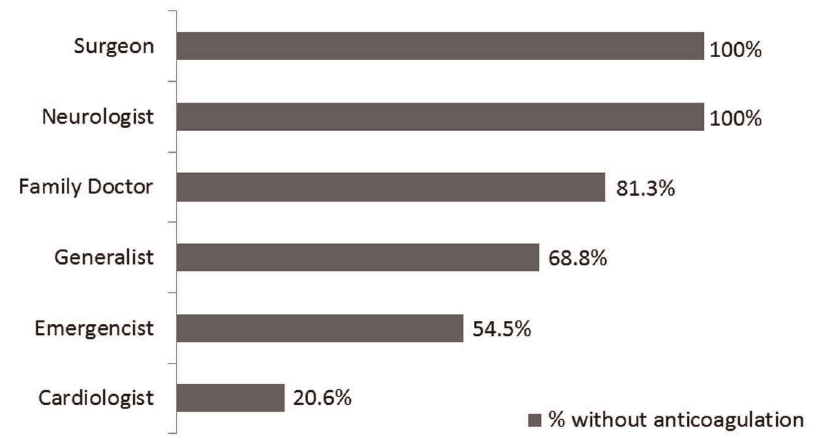
Figure 3 - Percentage of patients without anticoagulation therapy according to the specialty of the doctor who treated